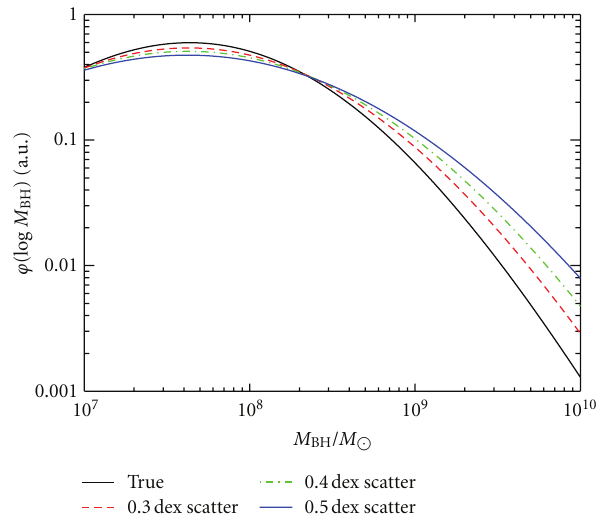
Figure 1: Illustration of the bias in the estimated BHMF derived from mass estimates. Shown is the true mass function (thick solid black line) for a simulated sample, and the mass function derived from the mass estimateswhen the statistical error in the mass estimates is 0.3dex (red dashed line), 0.4dex (green dot-dashed line), and 0.5dex (solid blue thin line). The massfunction estimated from the mass estimates is biased, especially at the high-MBH end and for large statistical